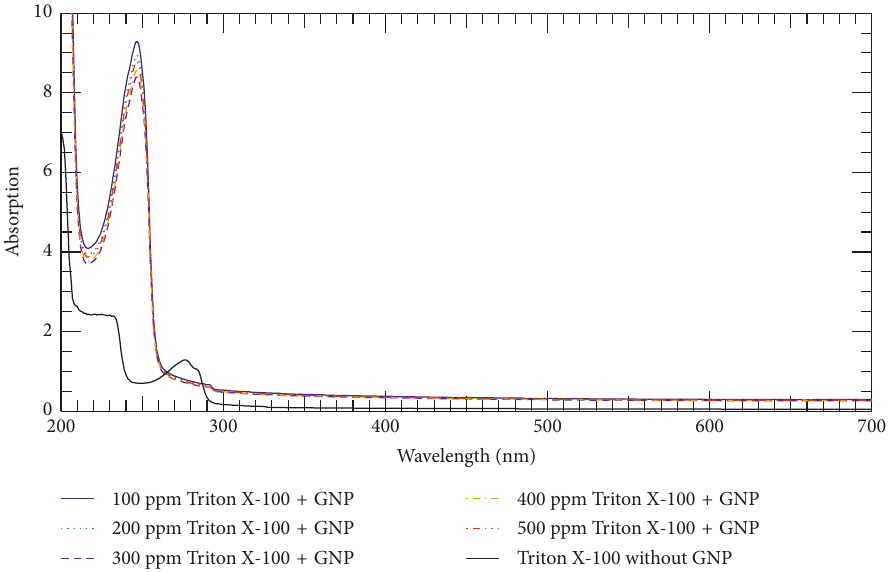
Figure 7: UV-Vis spectra of graphene nanoplatelets in Triton X-100 solutions after 30-minute ultrasonication.